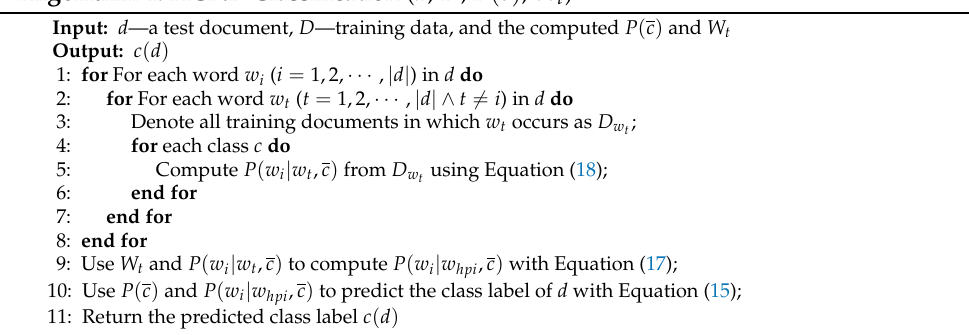
Algorithm 4: HCNB-Classification ( d , D , P ( c ) , W t